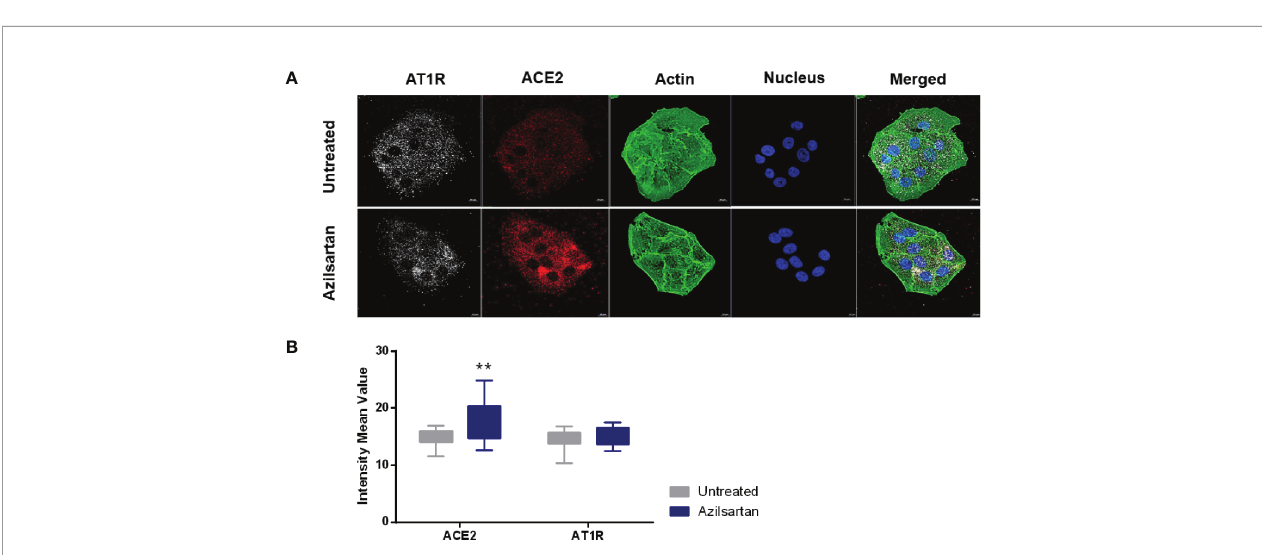
FIGURE 2 | Modulation of cell surface-expressed ATR1 and ACE2 molecules in Vero E6 cells non-infected and treated with Azilsartan (15 µM) for 72 hours by immuno fl uorescence microscopy. (A) The panel presents non-infected cells after incubation with Azilsartan (15 µM) and evaluating the fl uorescence corresponding to the ATR1, ACE2, Actin, and the nucleus of the cells. The merge of the images is displayed at the right of the panel. Images were acquired using a confocal microscope (Zeiss LSM 800) with a 63X/1.4 oil objective. (B) Quantitative representation of Mean Fluorescence corresponding to ATR1 and ACE2 molecule expression on VERO E6 cells treated or not treated with Azilsartan. ** P <